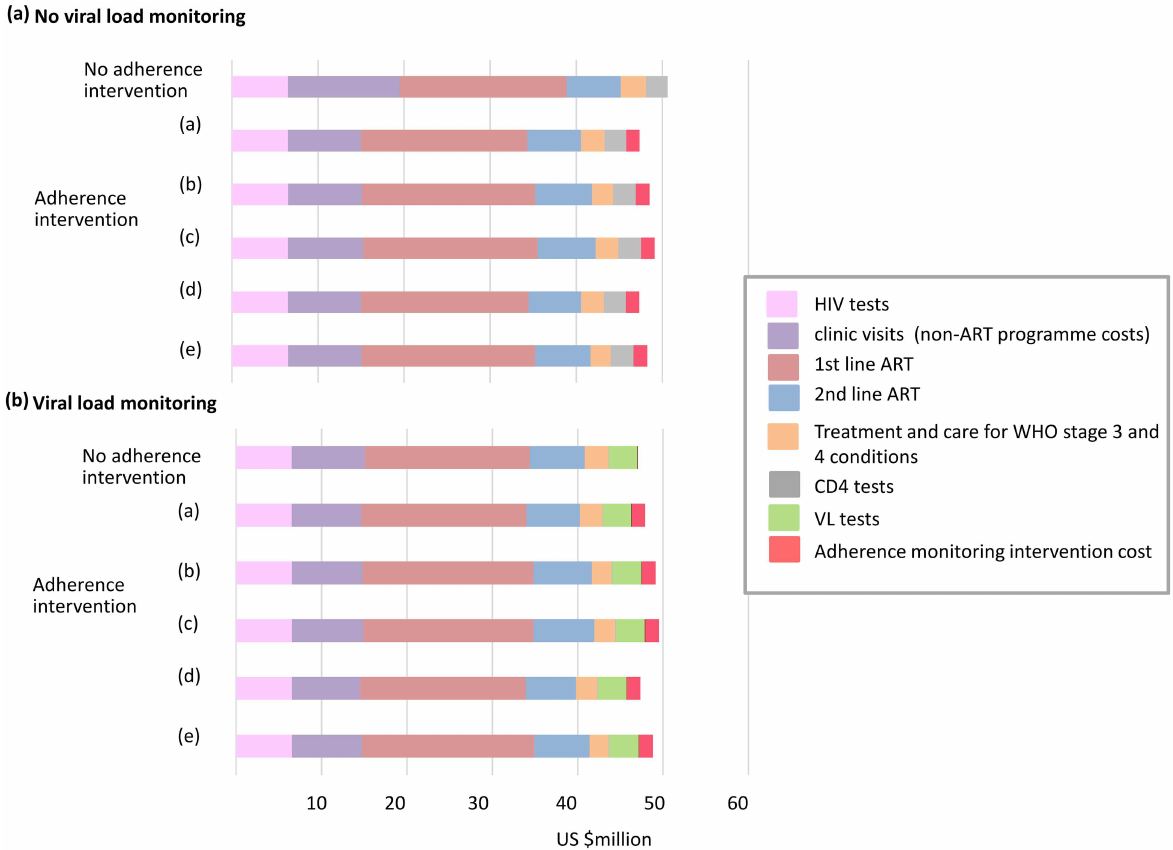
Fig 2. Overall programme costs according to components intervention has beneficial effect on ((a) adherence on ART only (b) adherence on ART + discontinuation of ART (c) discontinuation of ART only (d) adherence on ART + risk of resistance(e) adherence on ART + discontinuation of ART + risk of resistance). Costs in US$m per 3 months (mean 2017–2036, discountedat 3% per annumfrom 2015). For scenariowith 50% of peoplein whom the intervention has an effect, and a durableeffect. For illustrative purposes, the adherence interventionhas an arbitrarily selectedcost of $10 per year per person on